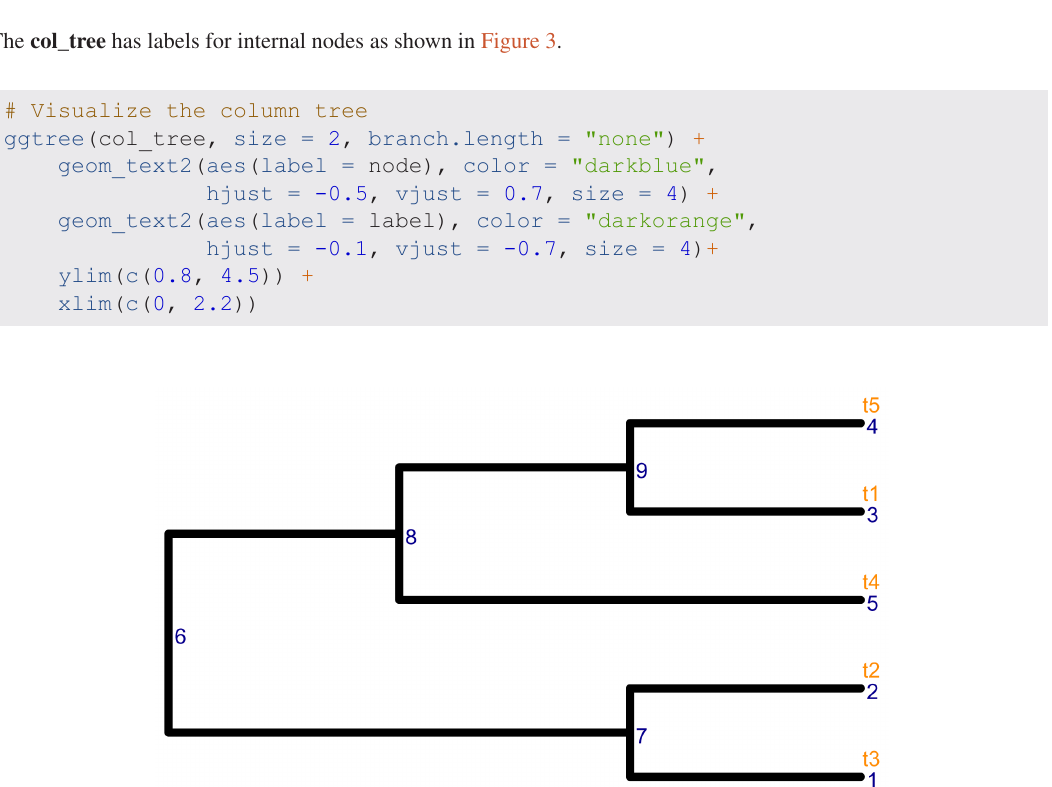
Figure 2. The structure of the row tree. The node labels and the node numbers are in orange and blue text, respectively.